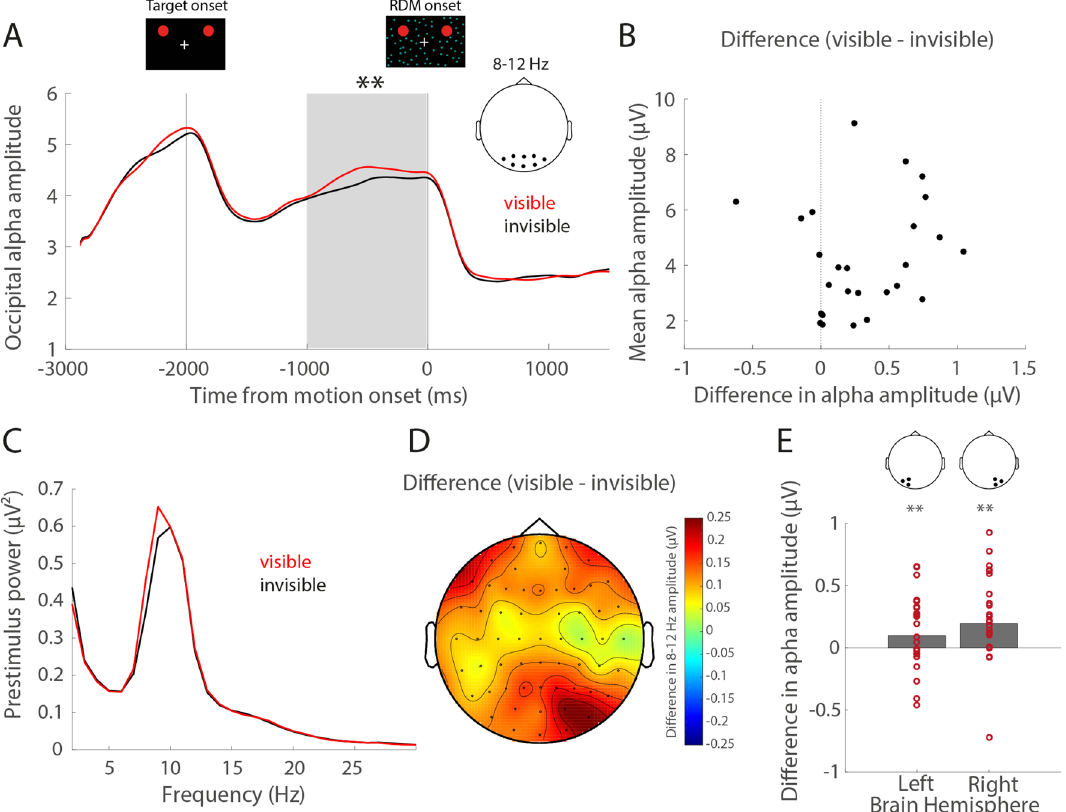
Figure 2. Prestimulus alpha amplitude as a function of perceptual suppression. ( A ) Average time course of alpha band (8–12 Hz) amplitudes for trials in which both targets remained subjectively visible (red, ‘neither’ condition) and trials in which both targets were perceptually suppressed (black, ‘both’ condition, N = 27). The zero mark denotes the onset of the RDM stimulus following which the targets were perceptually suppressed. Data represent the mean of all parietal-occipital electrodes. ** denotes a significant group difference in alpha amplitude as assessed by Wilcoxon signed-rank test ( p < 0.01). ( B ) Difference in parieto-occipital alpha (8–12 Hz) amplitude between visible and invisible conditions (visible–invisible) in the second preceding RDM onset for individual subjects as a function of the individual average 8–12 Hz amplitude in the second preceding RDM onset across perceptual conditions, outlier corrected > 2SD, N = 26. ( C ) Fast Fourier Transform (FFT) of the second preceding the RDM stimulus for visible and invisible trials across subjects. ( D ) Topography of the visible–invisible difference in 8–12 Hz amplitude in the second prior to RDM onset, N = 27. ( E ) Difference in parieto-occipital alpha (8–12 Hz) amplitude between visible and invisible conditions (visible–invisible) in the second preceding RDM onset, separated by left (electrodes O1, PO3, PO7) and right hemisphere (RH, electrodes O2, PO4, PO8) separately. Each dot represents the average of a single subject (outlier corrected > 2SD, N = 25). ** denotes a significant alpha amplitude difference between visible and invisible trials as assessed by Wilcoxon signed-rank test ( p < 0.01), separated by